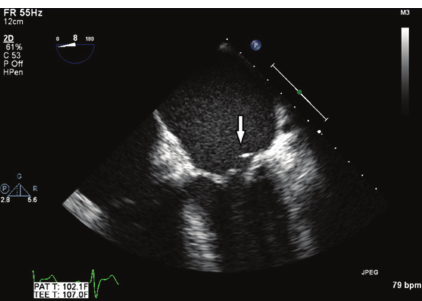
Figure 1: Transesophageal echocardiogram. A small vegetation (white arrow) on the mitral leaflet at the site of mitral valve repair.